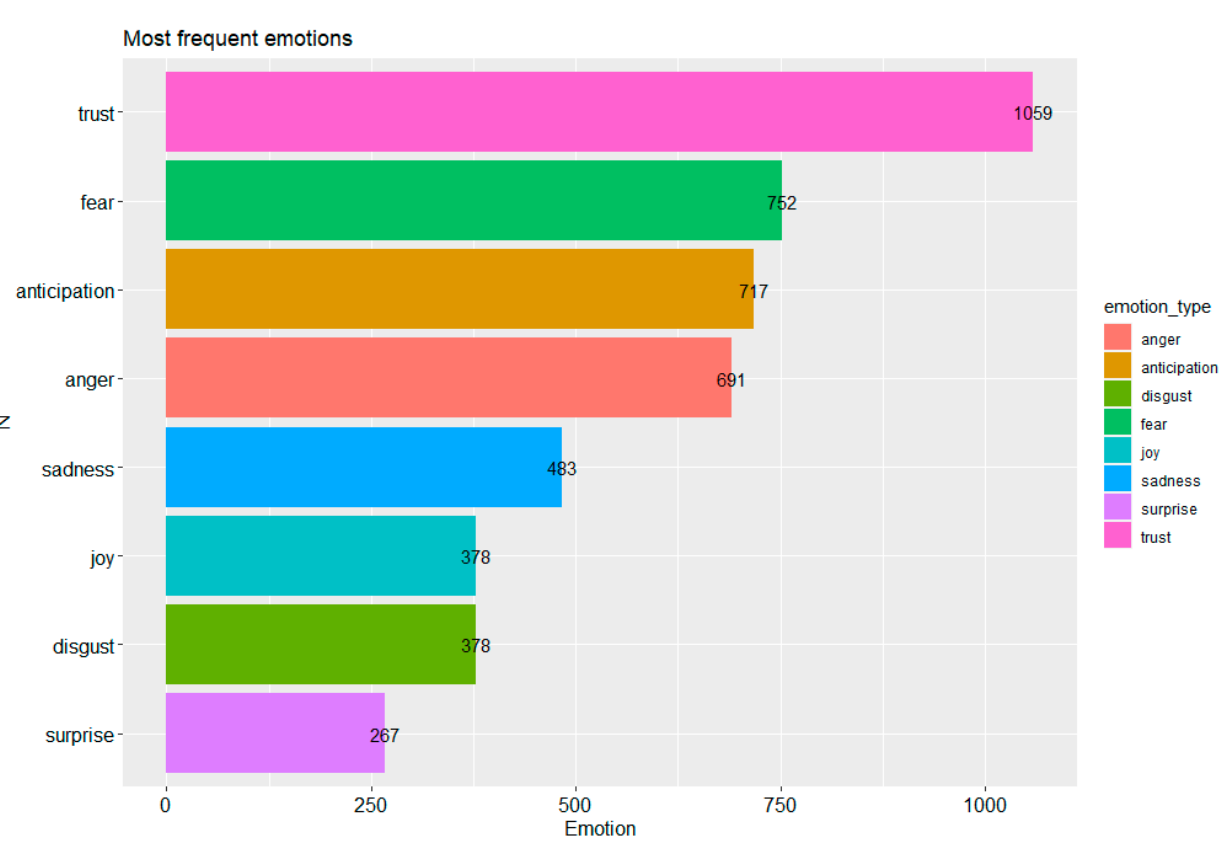
Figure 6. The most frequent emotions. Made using the ggplot2 and sentimentr libraries in R.